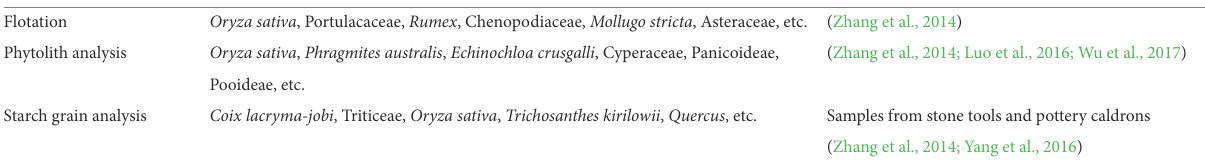
TABLE 1 Plant assemblages of the Shunshanji site. Analytical methods Plant